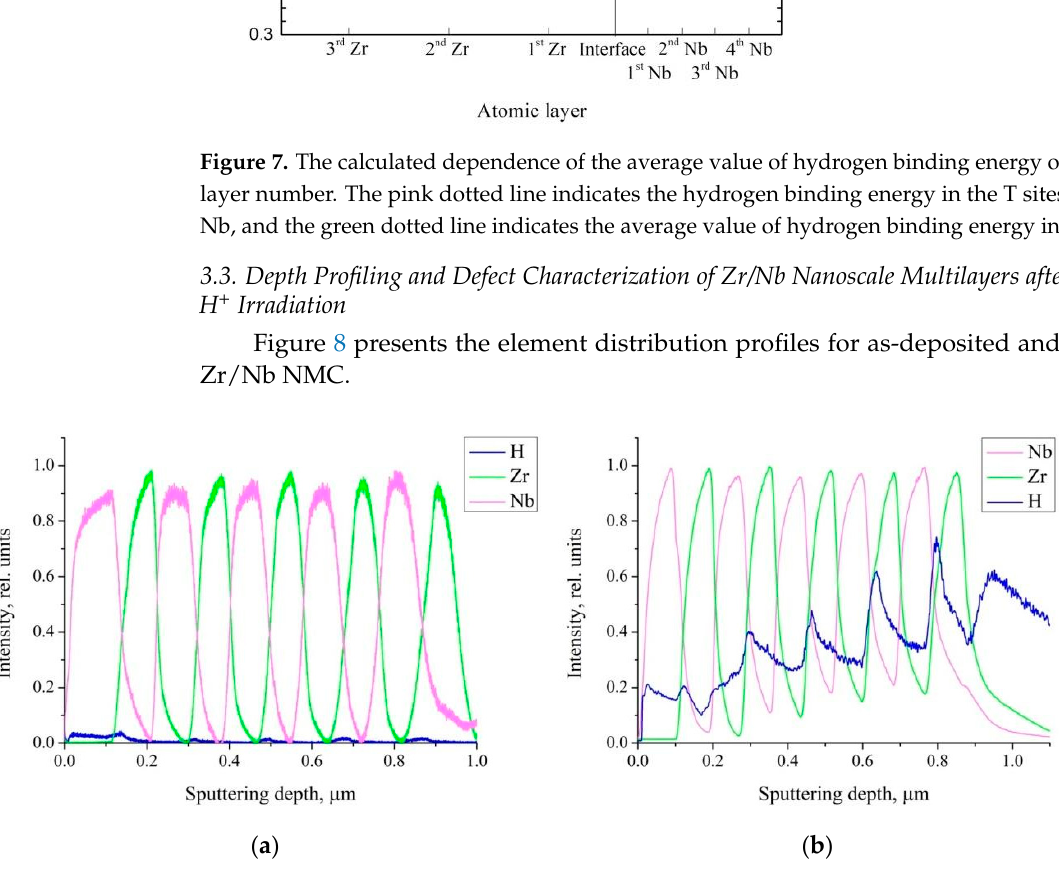
Figure 8. GD-OES profiles of element distribution for Zr/Nb NMC: ( a ) as-deposited, ( b ) H + irradiated.